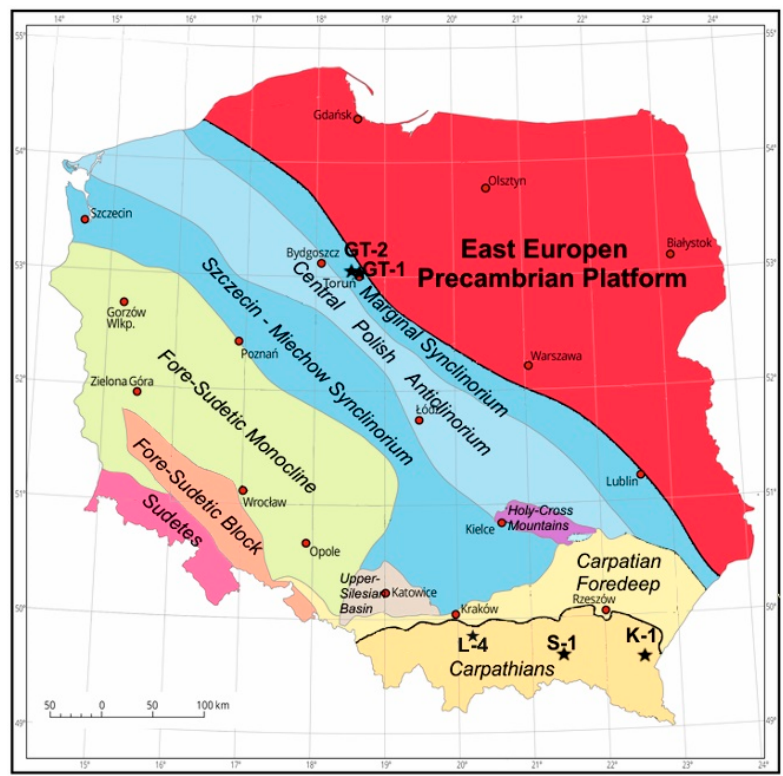
Figure 1. Location of boreholes in the study (GT ‐ 1, GT ‐ 2, K ‐ 1, S ‐ 1 and L ‐ 4) on the background of geological units in Poland; source: e ‐ podreczniki.pl—modified. Table 2. Stratigraphy and lithology of the formations drilled by GT ‐ 1 and GT ‐ 2 boreholes (on the basis of the report entitled